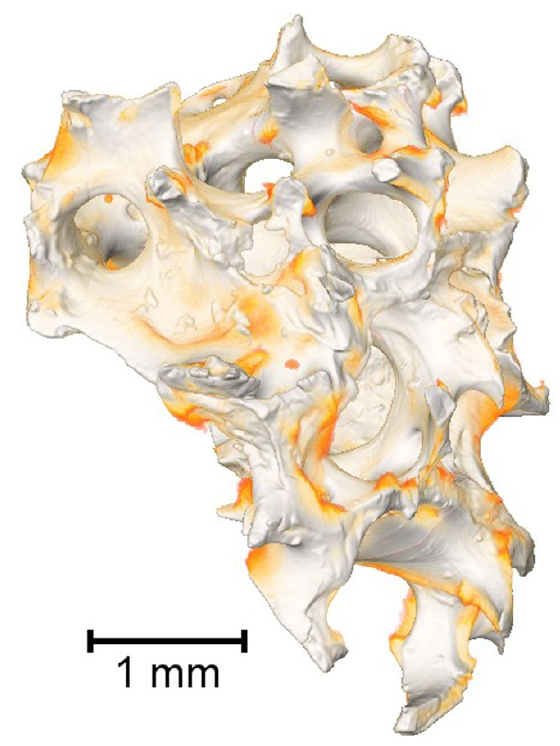
Figure 3. Architectonics of demineralized lyophilized human spongiosa (Micro-CT). Trabecular ar- chitecture: (80 kV, 8.6 µm/pixel; 1081 projections; 0.5 s exposition time). architecture: (80 kV, 8.6 µ m/pixel; 1081 projections; 0.5 s exposition